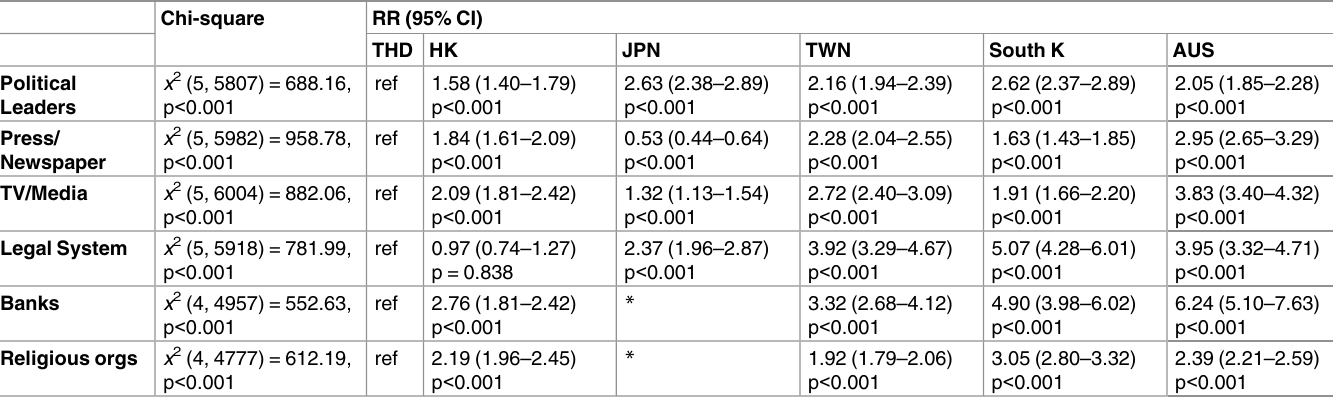
Table 2. Differences in ‘higher trust’ in institutions between